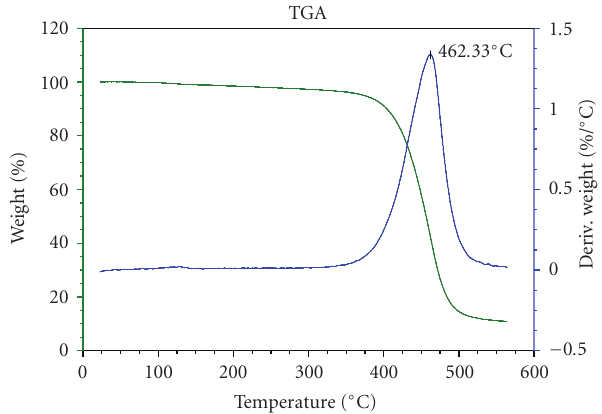
Figure 4: Thermogravimetric trace of POC(12,6).